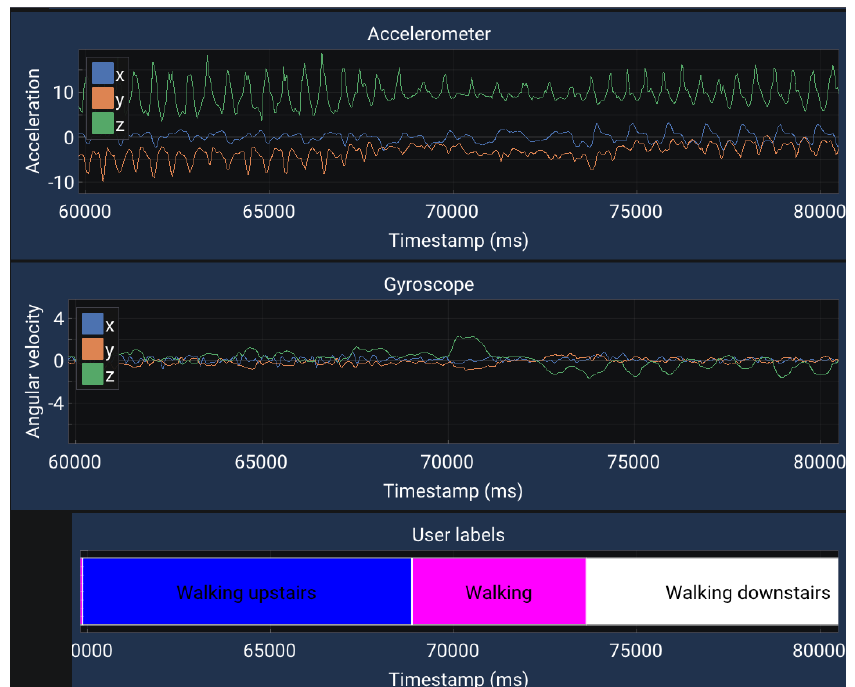
Figure A6. 20 s extracted from STAIRS session of subject T1.